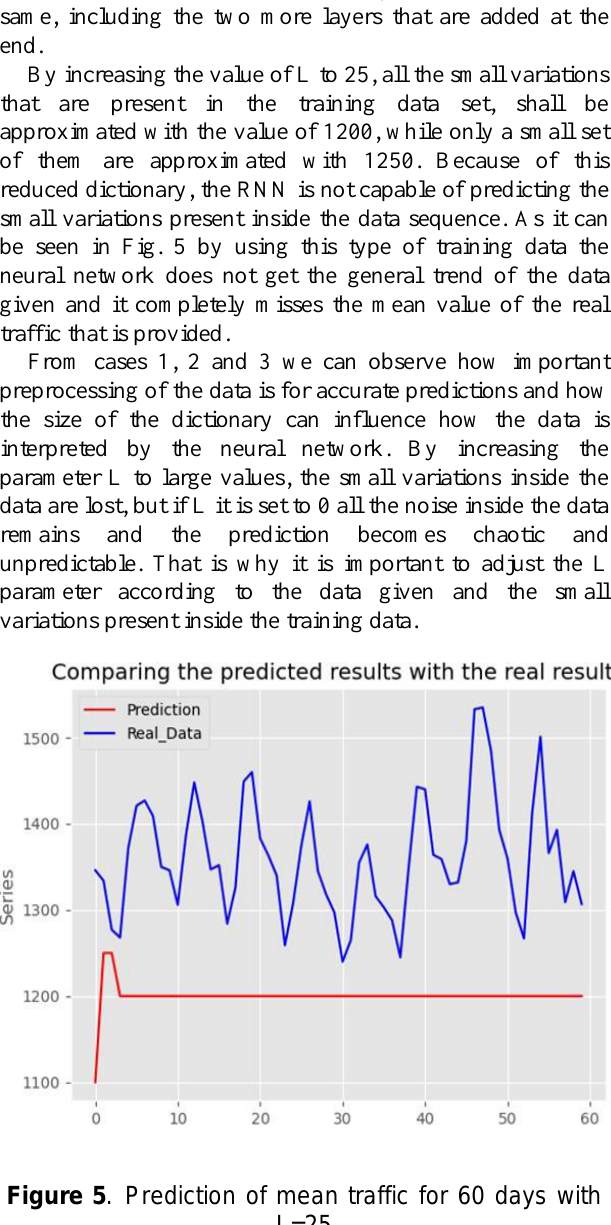
Figure 5 . Prediction of mean traffic for 60 days with